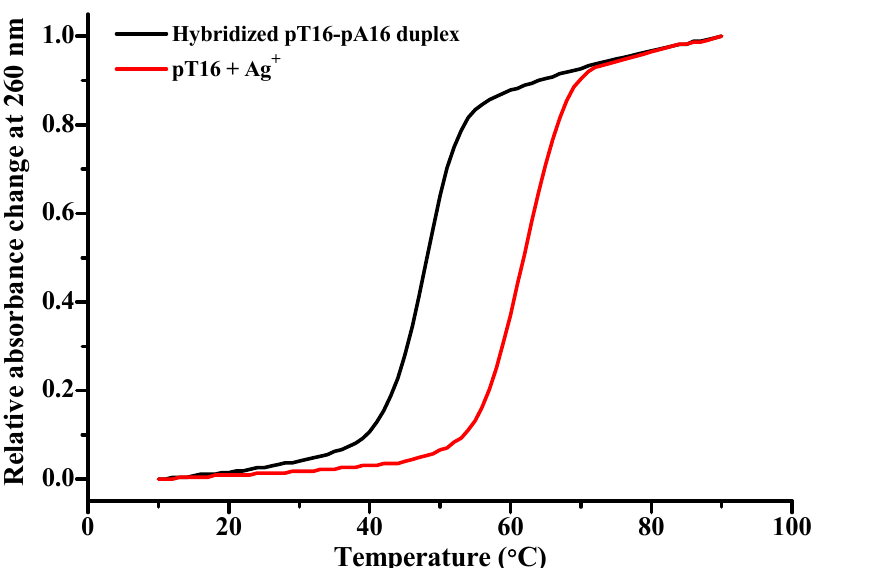
Figure 7. Thermal denaturation curves of 2.5 μ M hybridized pT16-pA16 duplex (black) and 5.0 μ M pT16 in the presence of 320 μ M AgNO 3 (red). The sample for pT16 under Ag + was prepared in 10 mM Tris-HAc buffer at pH 7.0, and the hybridized pT16-pA16 duplex in 10 mM Tris-HCl, 50 mM NaCl, 10 mM MgCl 2 pH